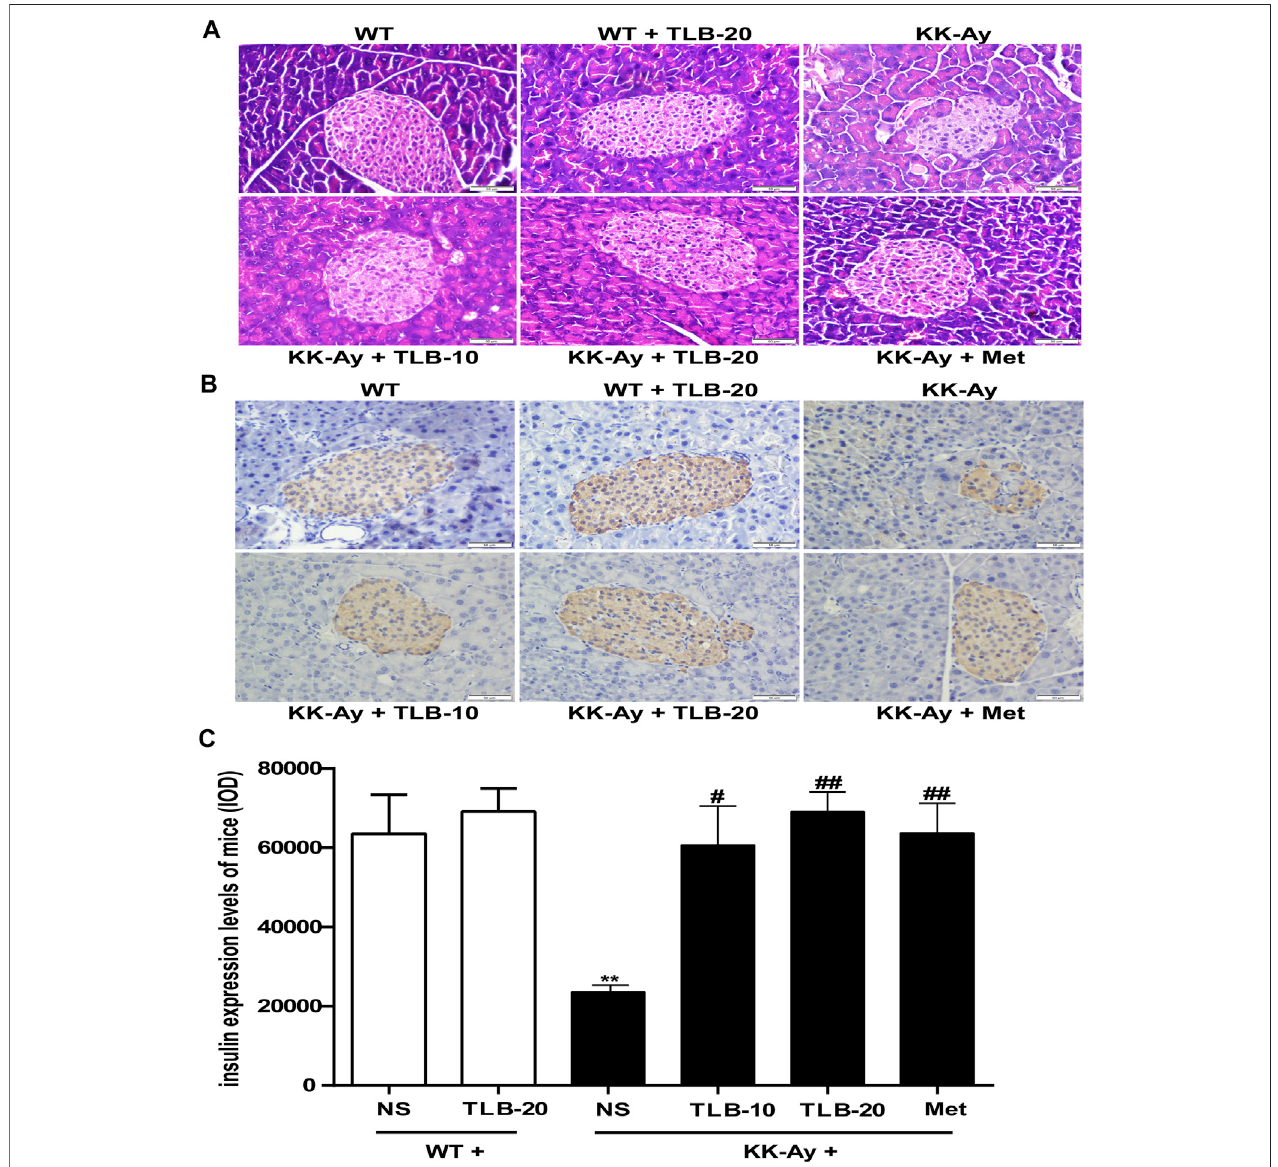
FIGURE4| TLBamelioratedisletsmorphologyandhypoinsulinemiainKK-Aymice. (A) RepresentativeimagesofHandEstainingofpancreases(×400,scalebar= 50 μ m). (B) Representativeimages ofIHC. (C) Quanti fi cation ofinsulin expression byusing Image-Pro Plus. **p < .01 vs. WTgroup; # p < .05, ## p < .01 vs. KK-Aygroup; n = 4 per group, mean ±